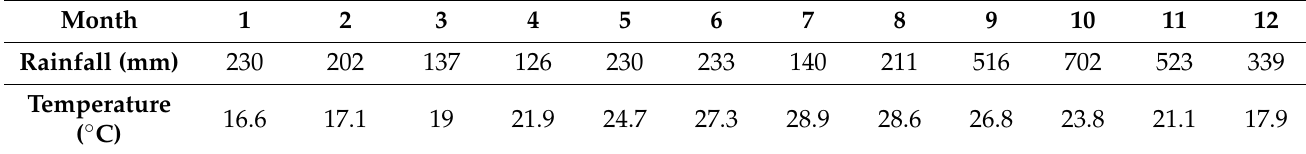
Figure 2. Hydrogeological profile of the Lanyang Plain. Reference Source: [21]. Table 1. Average temperature and rainfall in Lanyang Plain.